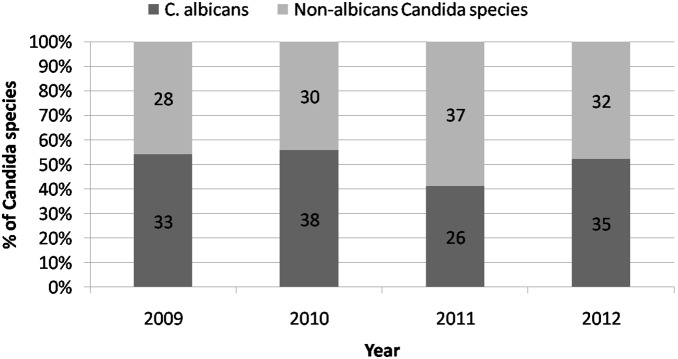
The ratio trends and number of C. albicans and non-albicans Candida from 2009 to 2012.